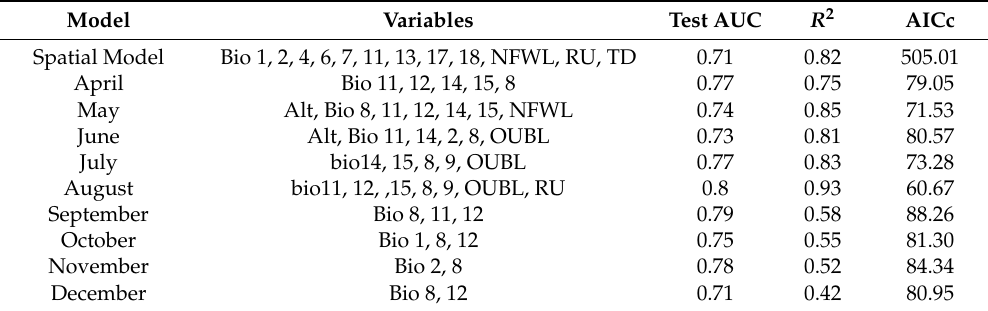
Table 3. Predicting variables used in building up the spatial and temporal models.